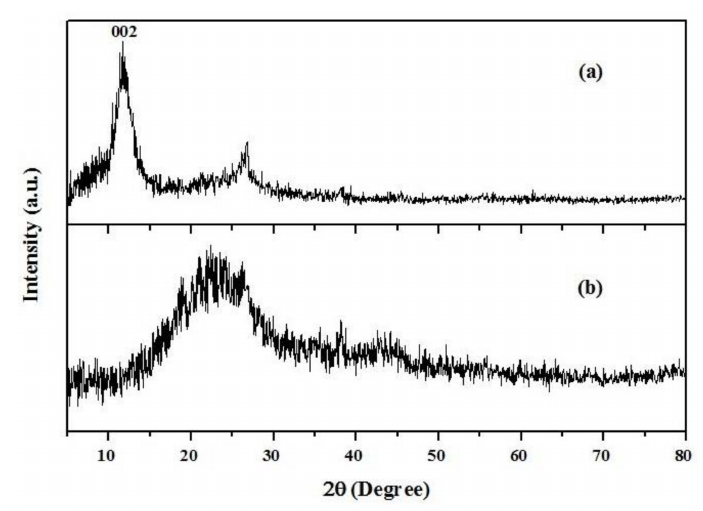
Figure 1. XRD (X-ray diffraction) spectra of ( a ) graphene oxide (GO) and ( b ) graphene oxide/poly(amidoamine)